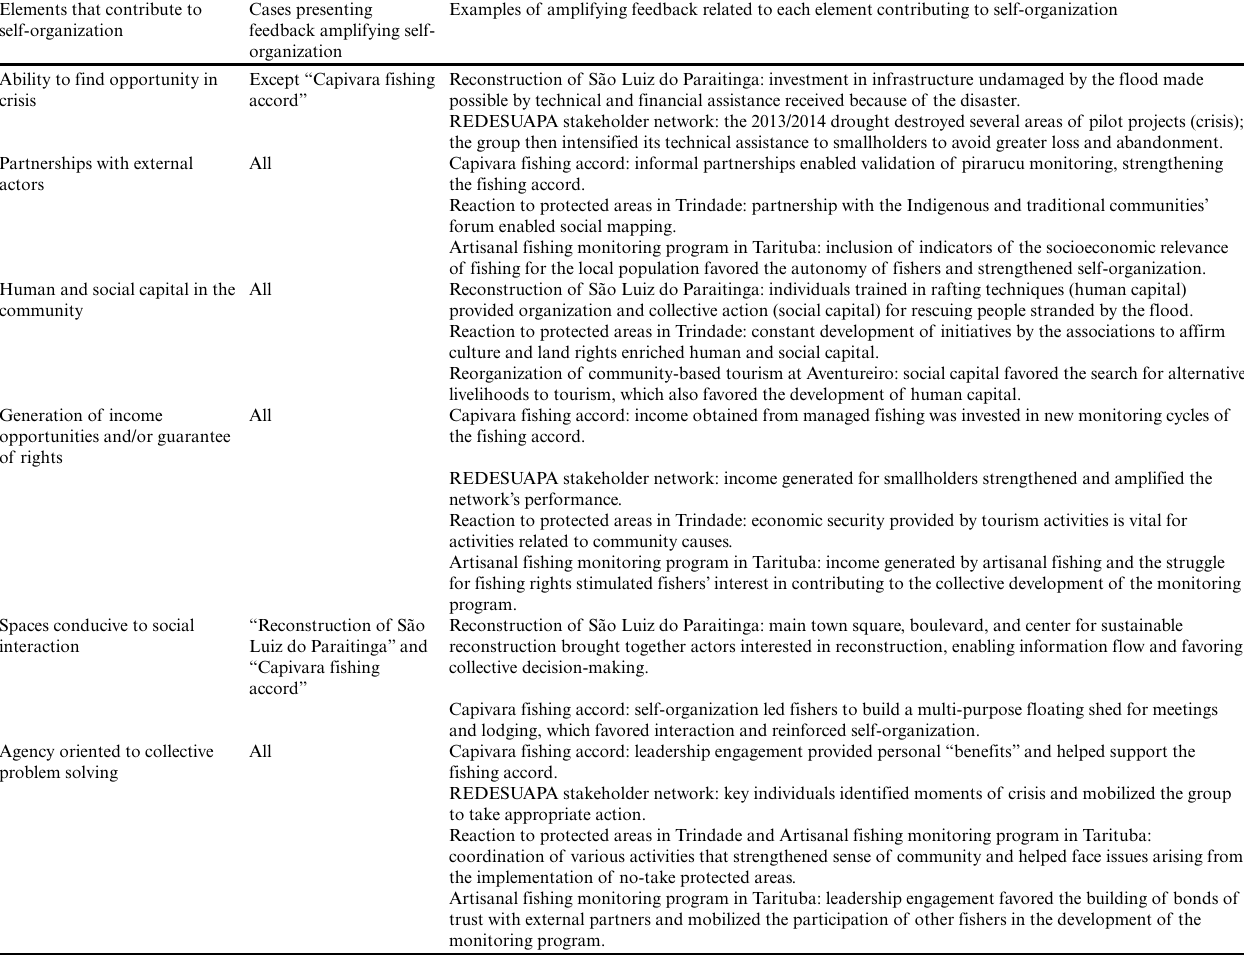
Table 3. Elements and examples of feedback amplifying community self-organization in the analyzed